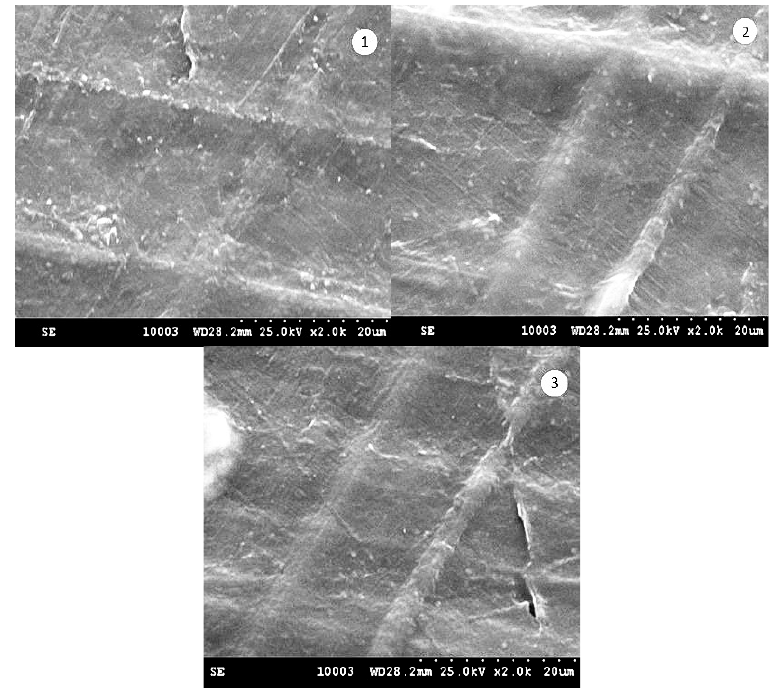
Figure 8. SEM images of PVA-BC 12/6 (1), PVA-BC 12/12 (2) and PVA-BC 12/18 (3) mem- branes.